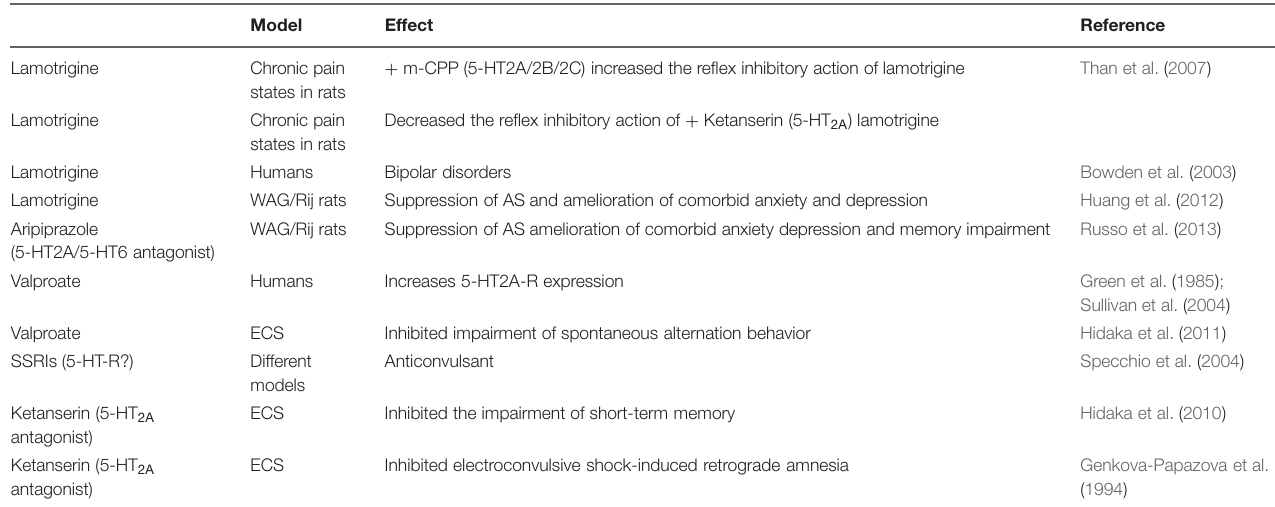
TABLE 3 | 5-HT 2A receptors in comorbidity between epilepsy and